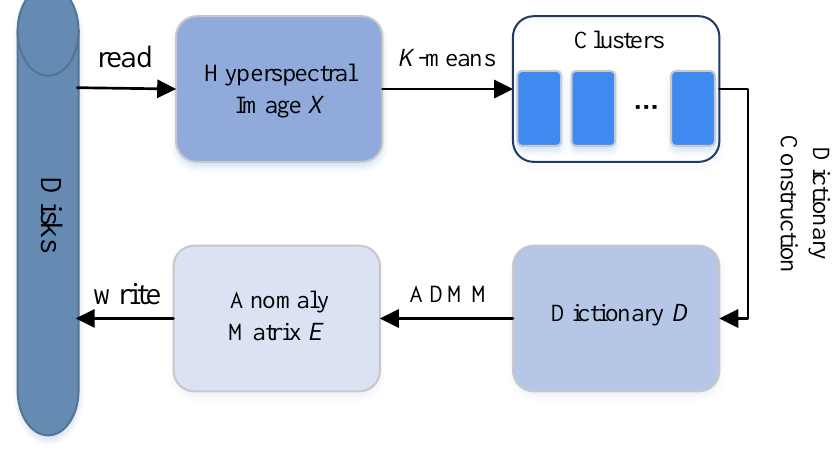
Figure 2. Flowchart of